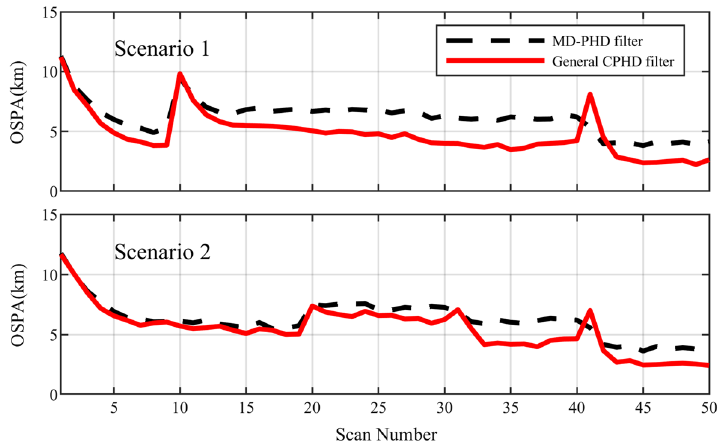
Fig. 9 OSPA metric of the general CPHD filter and the MD-PHD